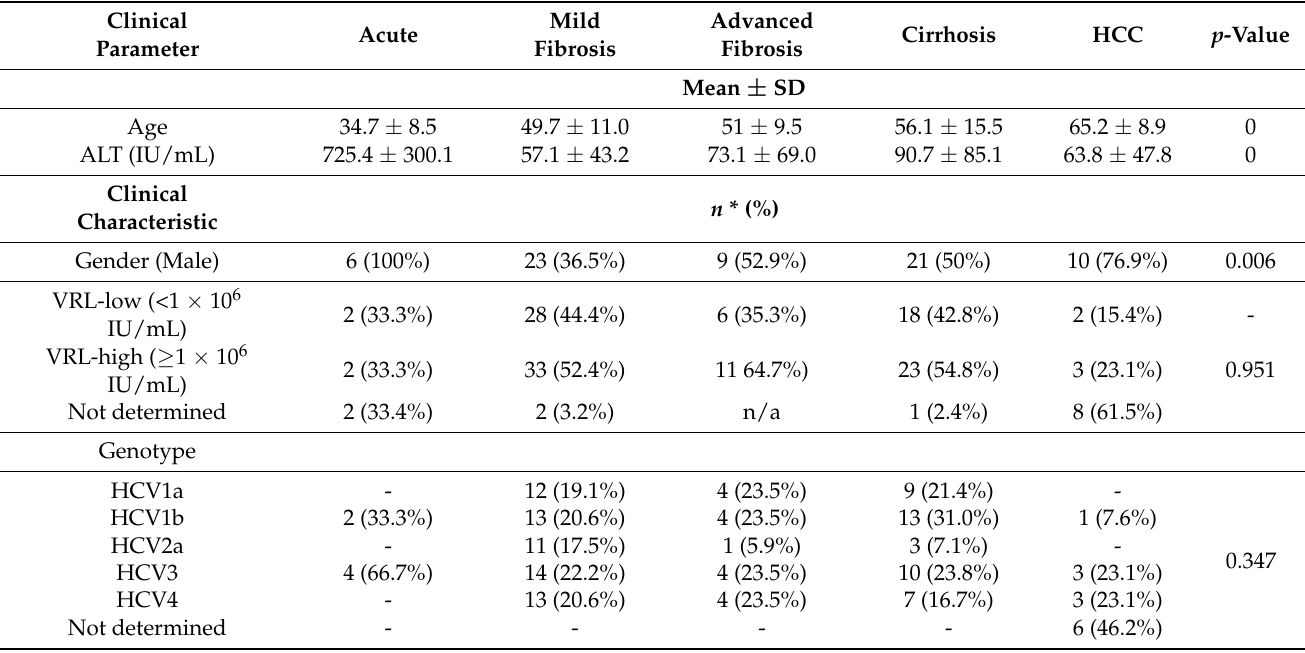
Table 2. Study demographics by disease